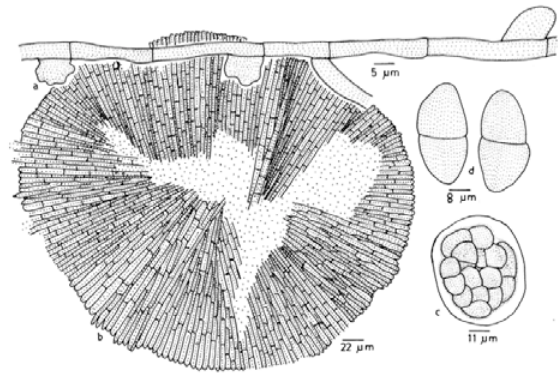
Figure 155. Asterina memecylonis a - Appressorium; b - Thyriothecium; c - Ascus; d - Ascospores